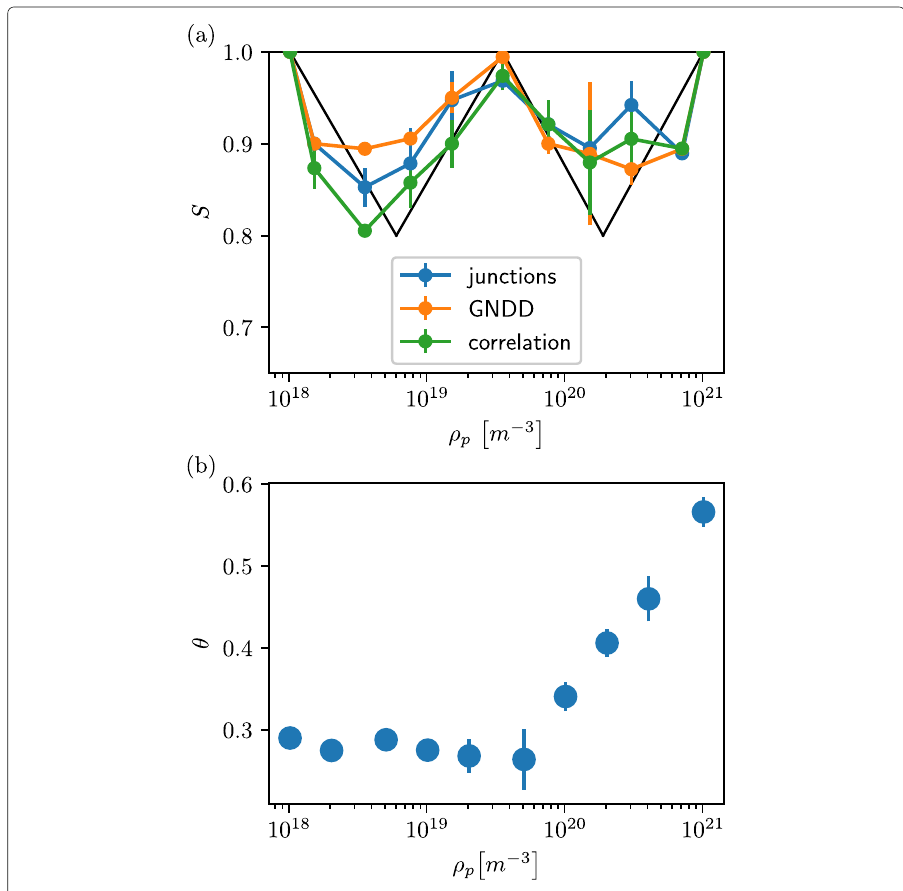
Fig. 5 The confusion curves compared to the exponent of relaxation a The confusion curves (classifier accuracy as a function of chosen threshold ρ p ) of different dislocation structure descriptors reach a maximum at the same ρ p . For these curves, the used number of PCs was 5 for junctions and GND density, and 10 for correlations. The error bars represent the standard deviation of classifier accuracy in 2-fold cross validation. b The maximum accuracy coincides quite well with the change in the relaxation rate, depicted by the exponent θ of power-law part in the strain rate curves of Fig.